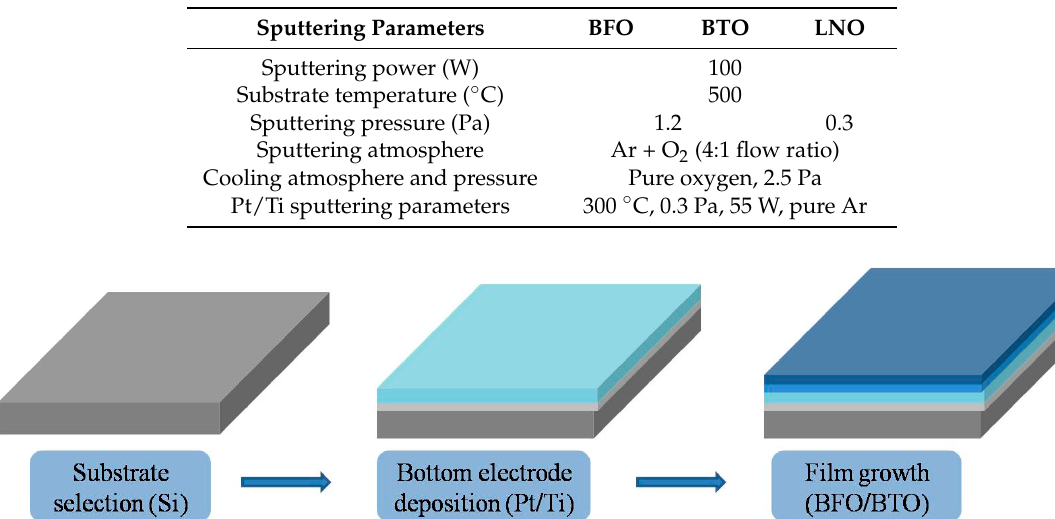
Figure 2. Schematics of the experimental procedures.